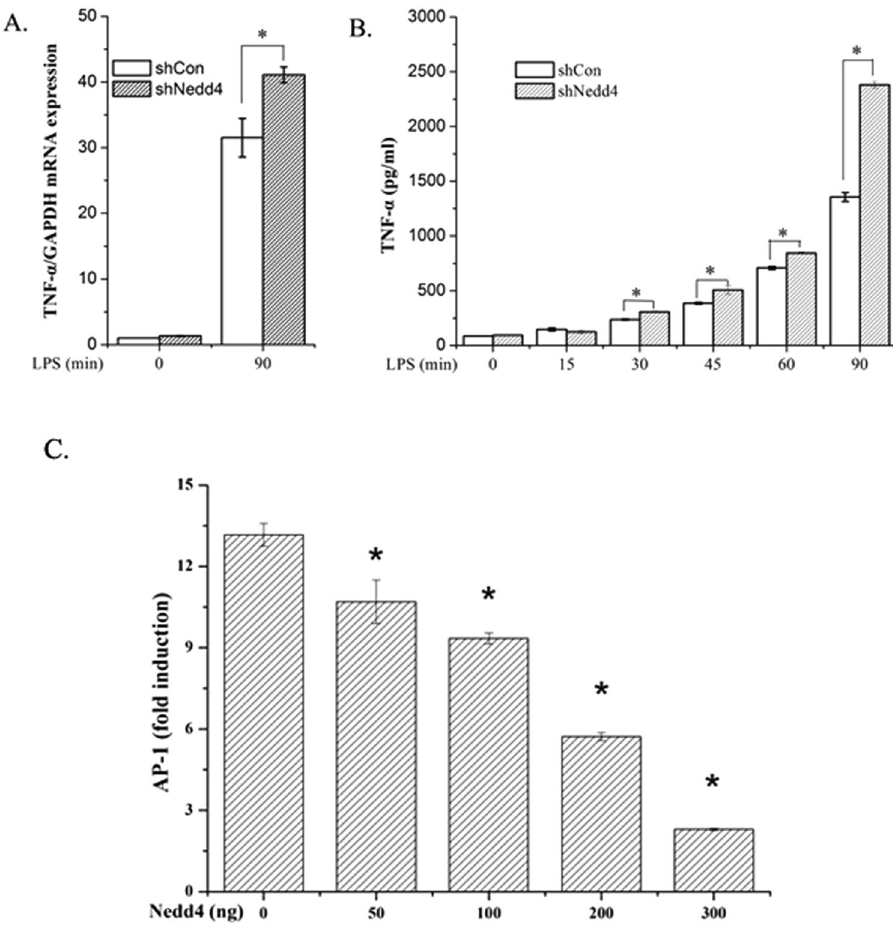
Figure 3. Nedd4 inhibits TNF- α production and AP-1 activation mediated by p38 α activation. ( A ) mRNA level of TNF- α was enhanced compared with control cells. Control and Nedd4-silenced iBMDM cells were stimulated with LPS for 90 min, and total RNA was extracted. After reverse transcription, TNF- α mRNA was analyzed with Q-PCR. ( B ) ELISA of TNF- α in supernatants from control and Nedd4-silenced iBMDM cells stimulated for 0–90 min (above lanes) with LPS. Data are representative of three independent experiments with similar results (mean ± s.d.) ( * , significant difference). ( C ) Nedd4 inhibits MyD88-dependent transcription of gene encoding AP-1. Luciferase assay of the induction of gene encoding AP-1 in lysates of 293T cells transfected with 150 ng pGL3-AP-1 (firefly-luciferase) reporter plasmid and 3 ng pGL3-TK (renilla-luciferase) reporter, and 50 ng MyD88-expressing plasmid plus 0, 50, 100, 200 or 300 ng Nedd4-expressing plasmid and cultured for 24 h. Empty control vector pcDNA3.1( + ) was added to each sample to ensure transfection of the same amount of DNA in each. Luciferase activity is normalized to renilla luciferase activity and is presented relative to basal luciferase activity. * , p < 0.05 compared with no Nedd4 group. Data are the mean ± s.d. of 4 samples in one experiment representative of similar results obtained in three independent